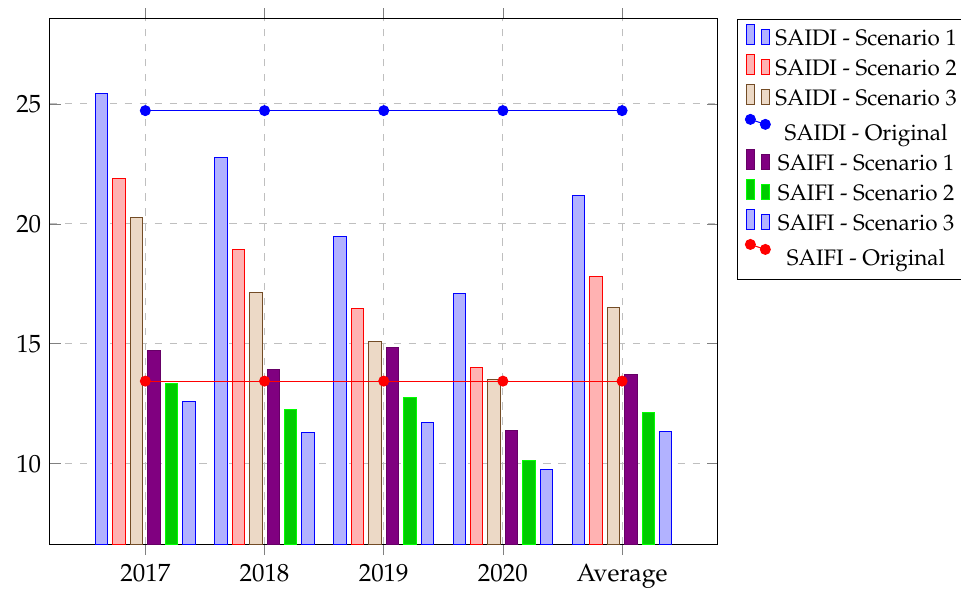
Figure 8. Annual and average reliability indicators of the best